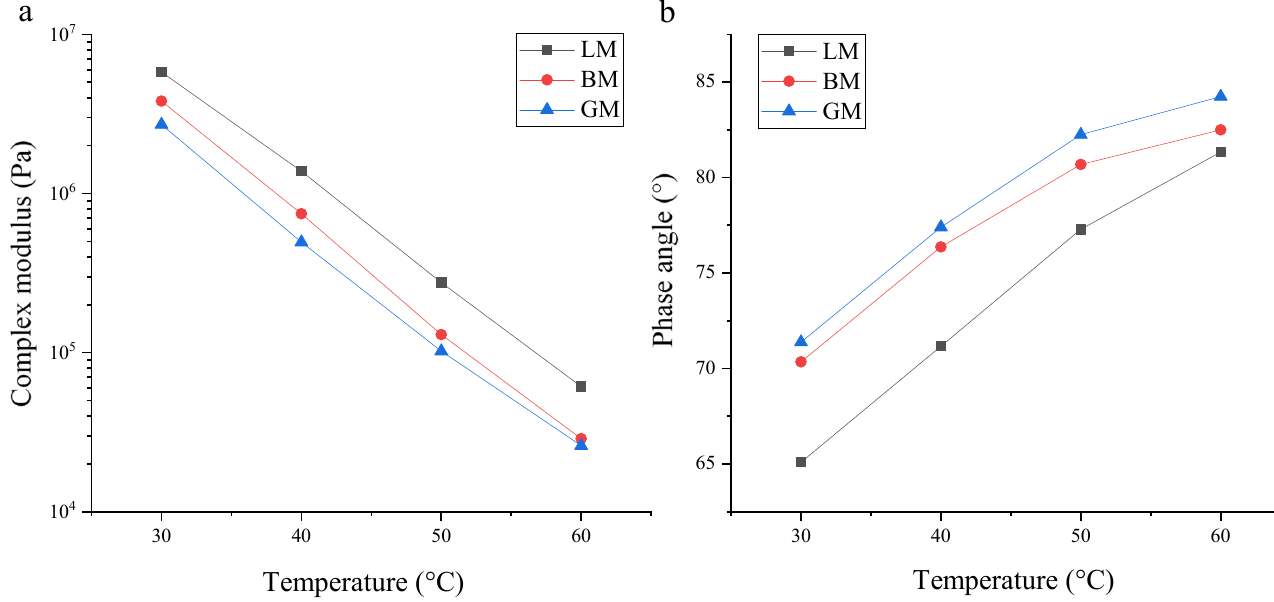
Figure 6. Rheological properties of asphalt mastics: ( a ) complex modulus and ( b ) phase angle. The rutting factor G*/sin δ , which is commonly used in the Superpave specification, characterizes the long-term deformation ability of asphalt mastic, with a high value in- dicating a high ability to permanently deform. Figure 7 shows the rutting factors of the different types of asphalt mastics. At the same temperature, the order of the rutting factor was LM, BM, and GM, which was related to the particle size, pore volume, and surface area. The particle size of LP was the smallest, which made it more dispersed in bitumen, so LM had better resistance to permanent deformation. The specific surface area and pore volume of BP were three times those of the granite mineral powder, so that the permanent deformation resistance of BM was higher than that of